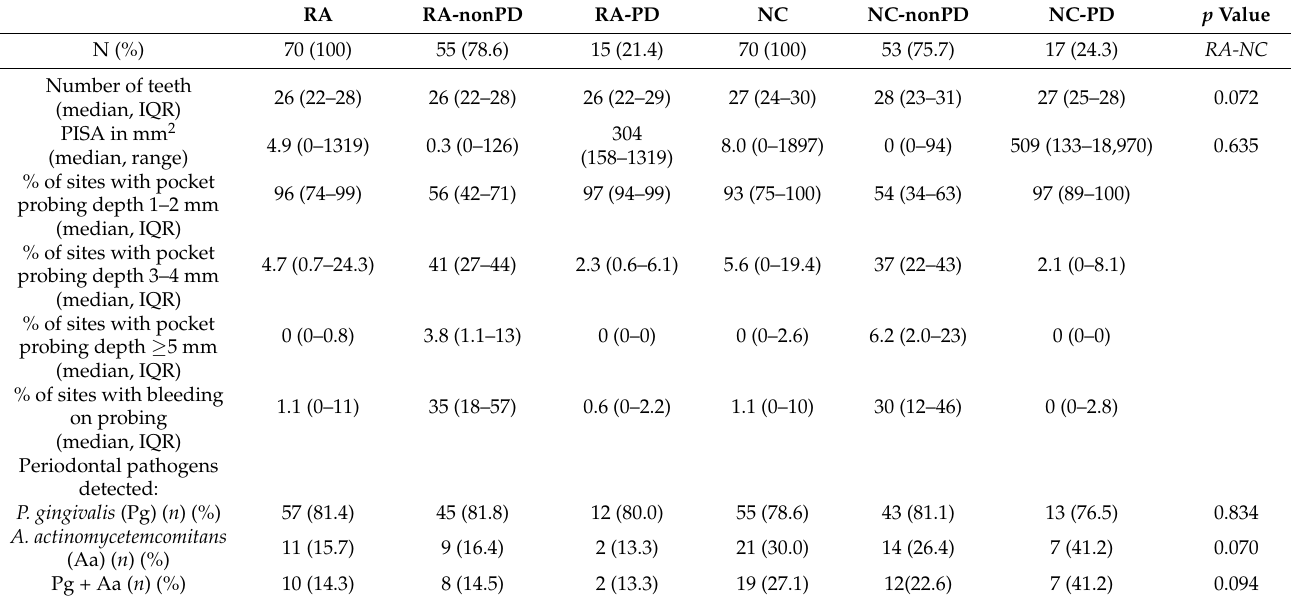
Table 2. Periodontal characteristics of patients with rheumatoid arthritis (RA) and non-RA controls (NC).